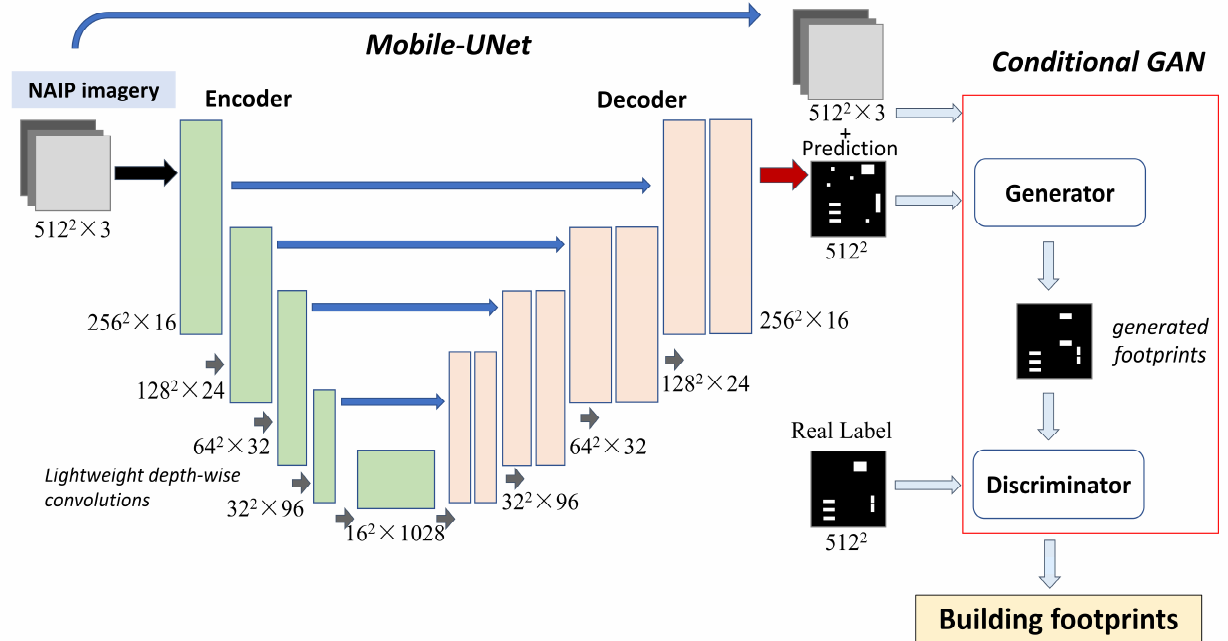
Figure 2. The diagram of the modeling framework for identifying individual building footprint based on the NAIP imagery.